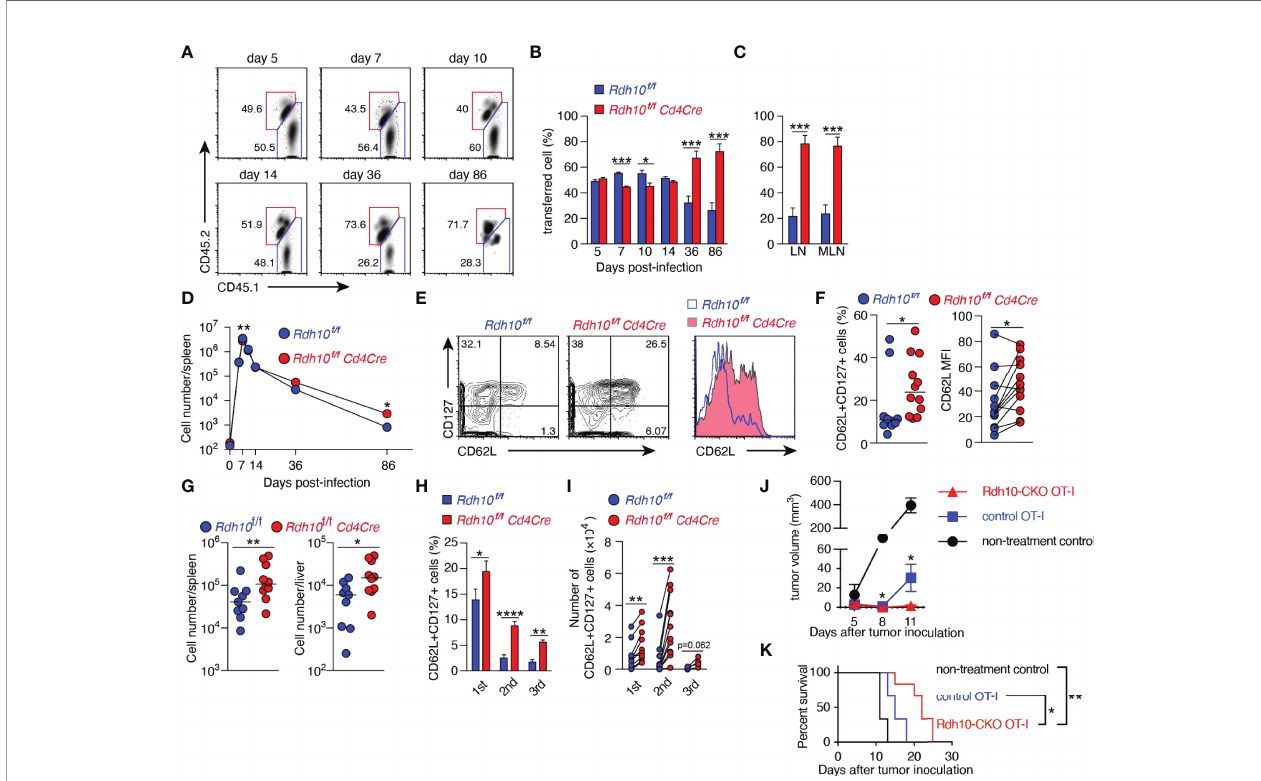
FIGURE 3 | Rdh10 de fi ciency enhances the generation of central memory T cells. (A – F) OT-I cells were isolated from Rdh10CKO (CD45.1 + CD45.2 + ) and control (CD45.1 + ) mice, mixed at a ratio of 1:1, and then intravenously transferred into the B6 host (CD45.2 + ). On the next day, the mice were intravenously infected with LM-OVA. (A) Representative dot plots showing the frequency of transferred OT-I cells in the spleen on the indicated days post-infection (pi). (B, C) Frequencies of the indicated OT-I cells among total transferred OT-I cells from the spleen (B) and lymph nodes ( C , 86 days pi). (D) Kinetics of OT-I cell number in the spleen. Symbols show median values. Data represent n = 5 (day 0), n = 8 (day 5, 7, 10, and 14), and n = 12 (day 36 and 86) mice from two independent experiments (B – D) . (E, F) Frequency of CD62L + CD127 + T CM (left) and the level of CD62L expression (right) in OT-I cells from the spleen in the memory phase (>30 days pi). Representative dot plots and histogram (E) . Data represent n = 10 (left) or n = 12 (right) control OT-I cells and n = 12 Rdh10CKO OT-I cells (F) . (G) Memory OT-I cells were transferred into B6 mice, and OT-I cells were counted in the spleen and liver on day 5 after LM-OVA re-challenge (1 × 10 6 CFU/mouse). (H, I)